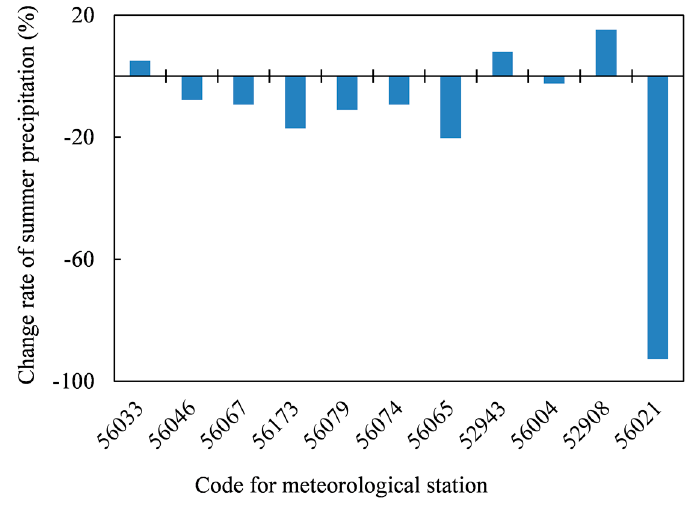
Figure 4. Change rate of summer precipitation (July–September) for all 11 meteorological stations within the source regions. Change rate was estimated by dividing the difference between the mean summer precipitation (mm) for two periods (before 1985 and after 1985) by the mean summer precipitation (mm) before 1985 for each station. See Table 2 for meteorological stations information.